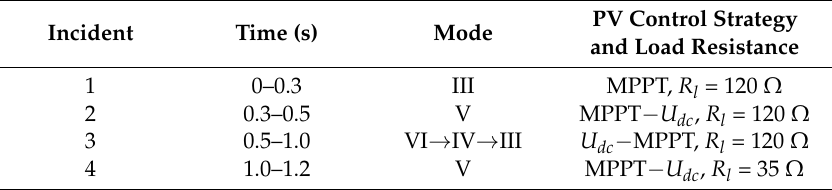
Table 2. Simulated PV working conditions.